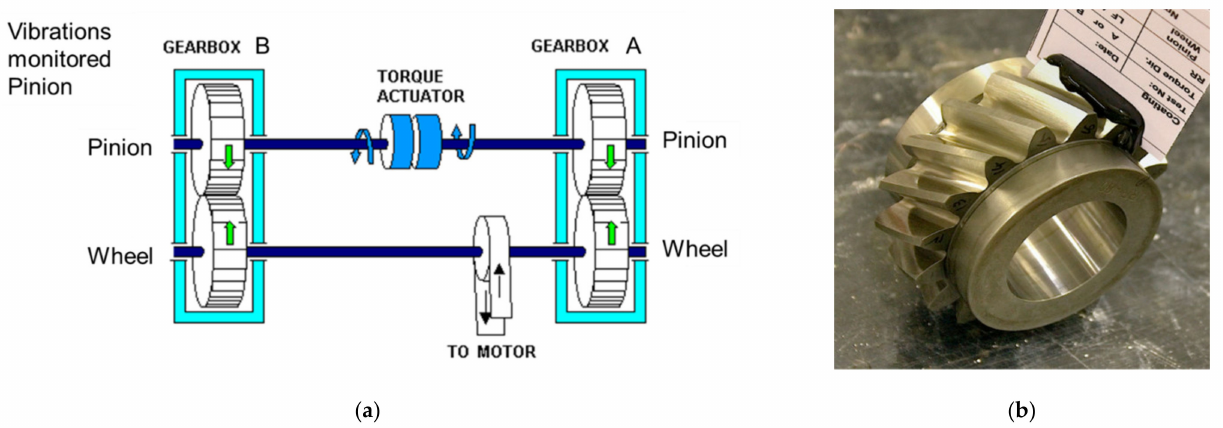
Figure 5. ( a ) Representation of the back-to-back test setup; ( b ) 16 tooth pinion when new (teeth labelled